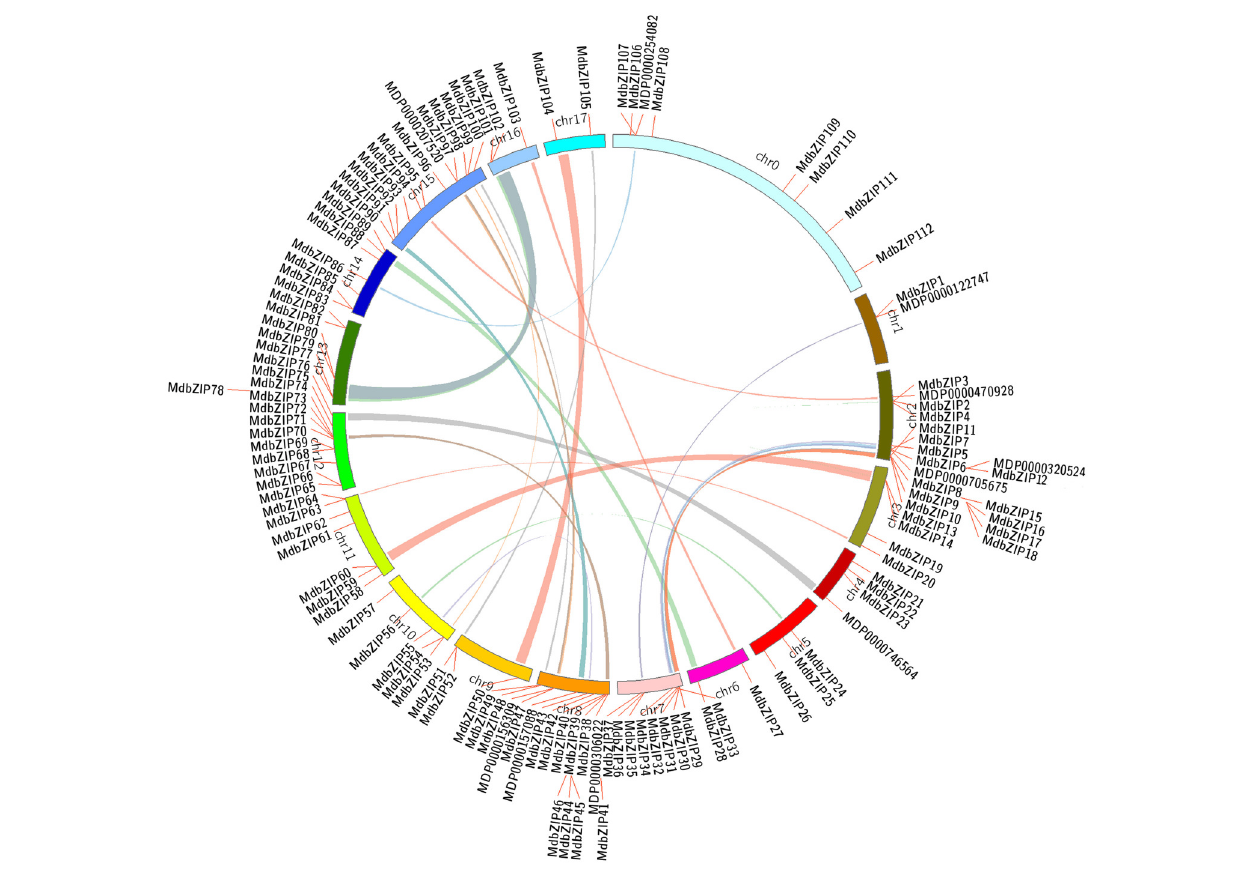
FIGURE 2 | Distribution and synteny analysis of apple bZIP genes. MdbZIP genes are indicated by vertical orange lines. Colored bars denote bZIP syntenic regions on the apple genome.